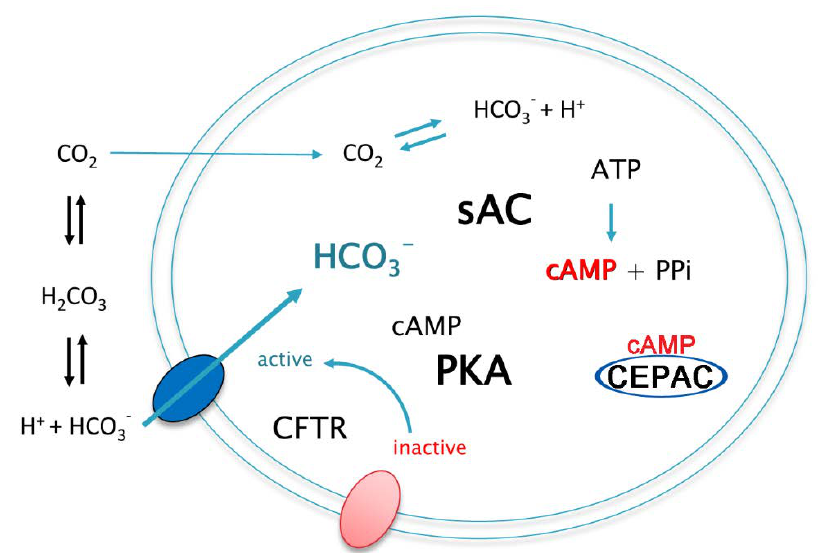
Figure 7. Mechanism of cystic fibrosis transmembrane conductance regulator (CFTR) activation in the sAC-CEPAC-CFTR cell. In the sAC-CEPAC-CFTR cell, CFTR is activated by PKA- (protein kinase A) dependent phosphorylation causing the channel to open. Bicarbonate influx results in cAMP synthesis catalyzed by sAC tr . cAMP activates PKA which in turn activates CFTR through phosphorylation.